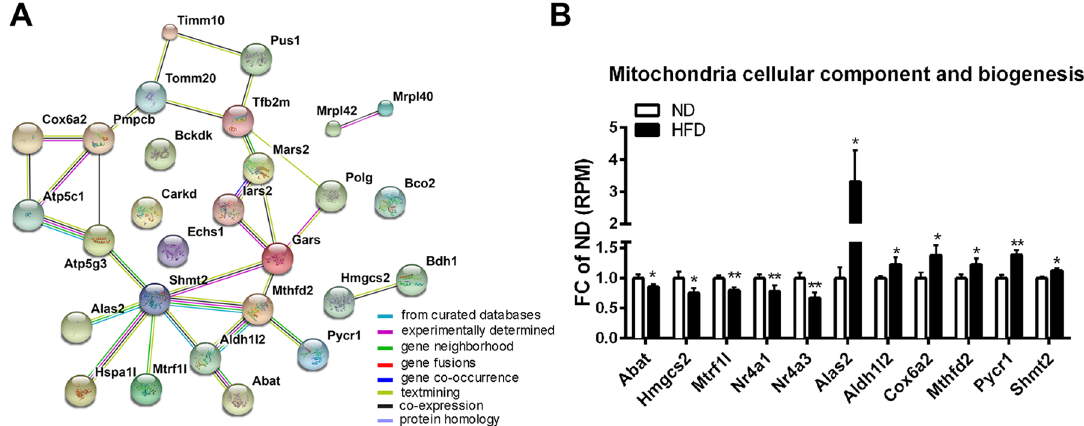
Figure 7. HFD significantly modulates genes associated with mitochondrial components. ( A ) Protein interaction network of significantly affected genes related to mitochondrial cellular components using String (v.10.0, http://string-db.org/). The edge represents predicted functional associations. ( B ) Representative genes of significantly changed mitochondria cellular component in RNA-seq datasets. Fold change (FC) of ND was calculated from the number of reads per million (RPM) for each gene and each sample. Statistics is by edgeR, * p < 0.05; ** p <